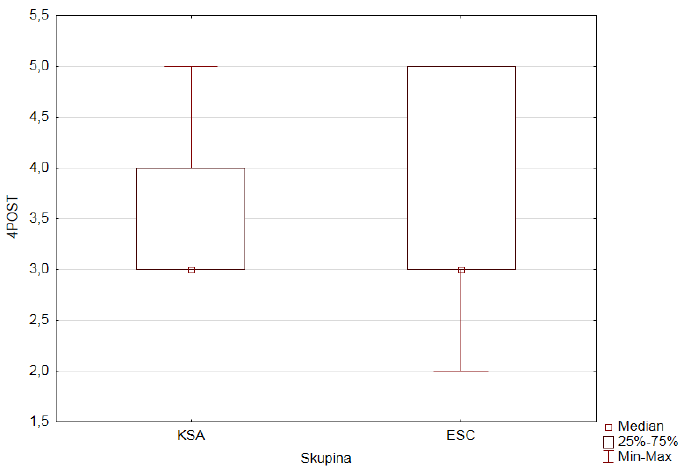
Figure 12. The box graph of the fourth item of the posttest - 4POST.